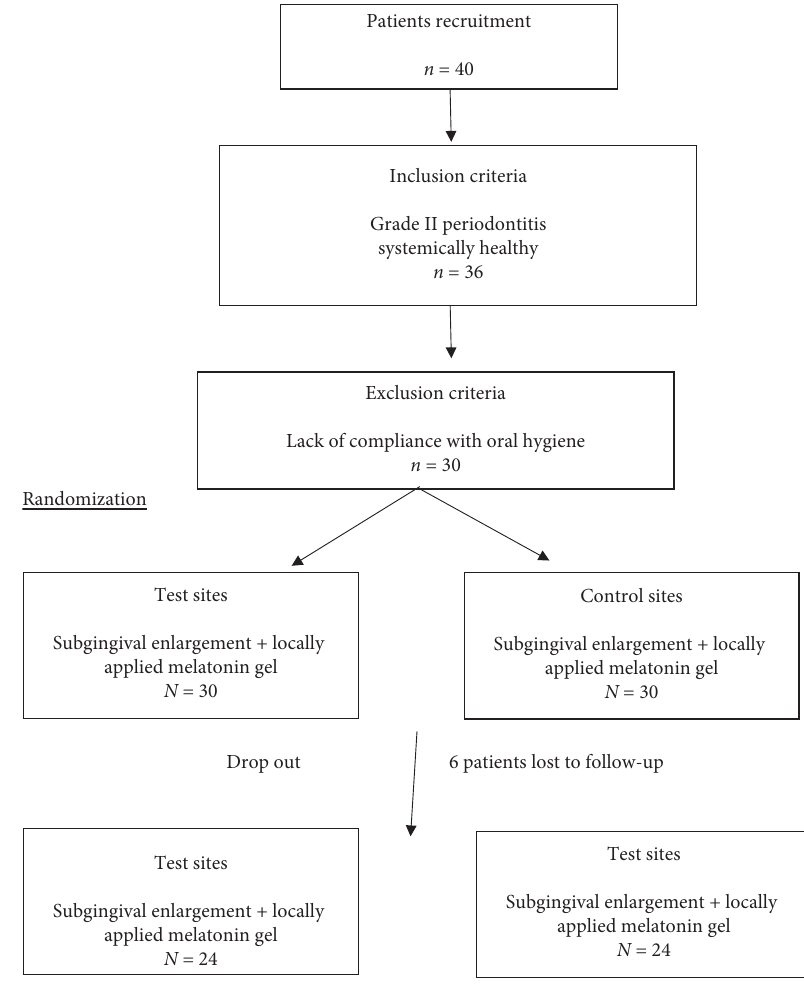
Figure 1: Flowchart of the